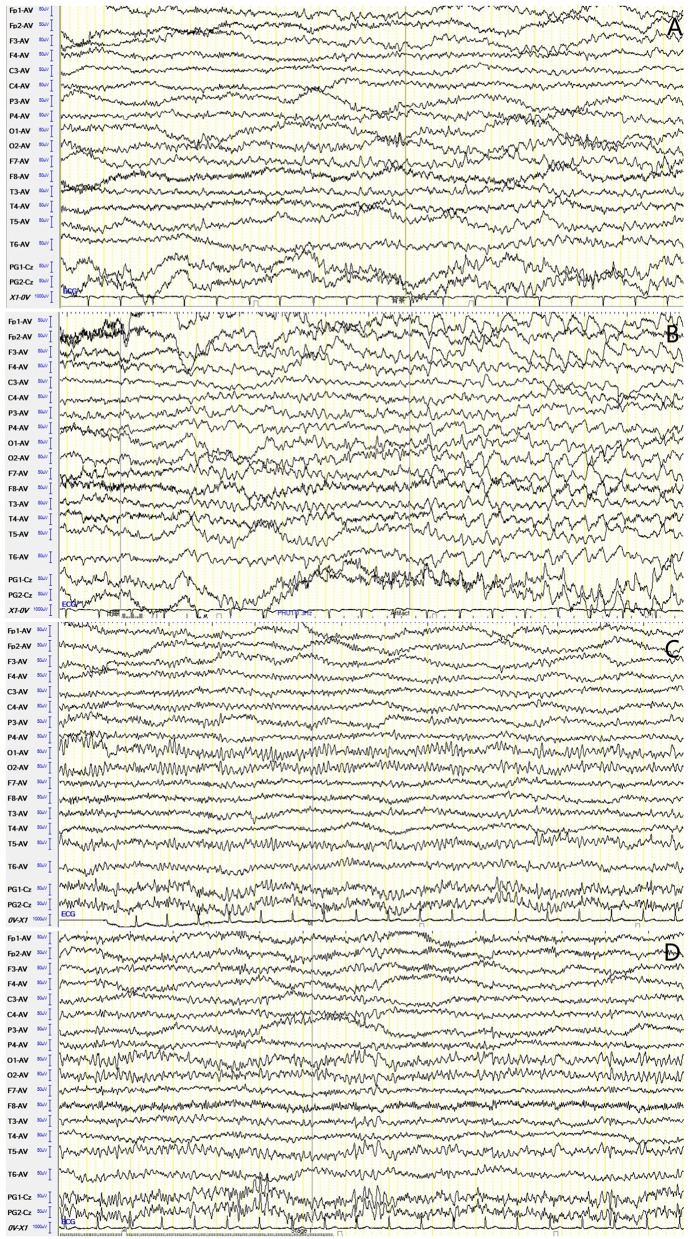
Case 17, male, 64 years old, who was diagnosed with anti-γ-aminobutyric acid B receptor (GABABR) encephalitis. (A,B) Twenty-one days after onset and before immunotherapy, electroencephalogram (EEG) showed slow waves in the left temporal region (A), and a subclinical electrographic seizure originating from the left temporal region (B). (C,D) Ten days after immunotherapy, EEG showed significant improvement in background activities (C), with scatted slow waves in the left posterior region (D).